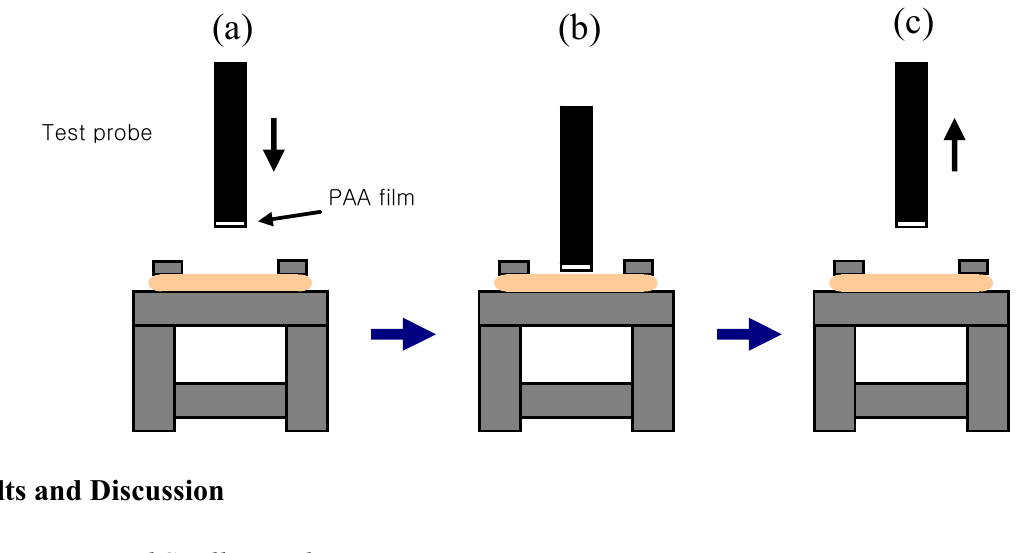
Figure 1. Process of the mucoadhesive test by the texture analyzer with a mucoadhesive holder. ( a ) The probe with hydrated poly(acrylic acid) (PAA) film was moved downward. ( b ) Dried PAA film was attached to pig buccal mucosa. ( c ) The probe is withdrawn at a specified